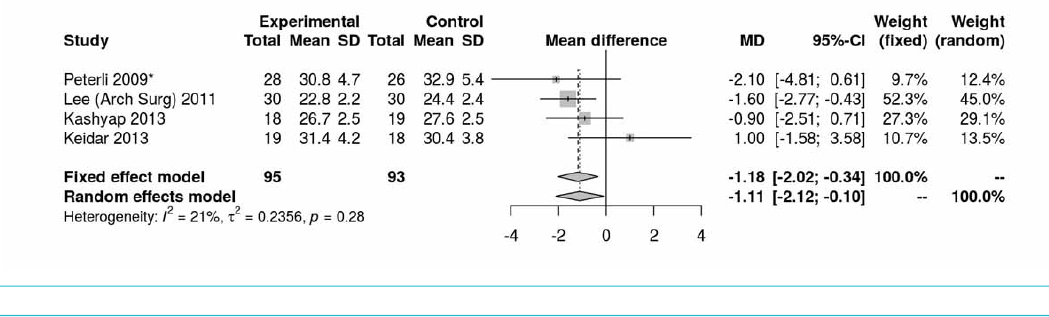
Figure 7b: Fasting blood glucose at 24 months (analysis of studies including only patients with type 2 diabetes).